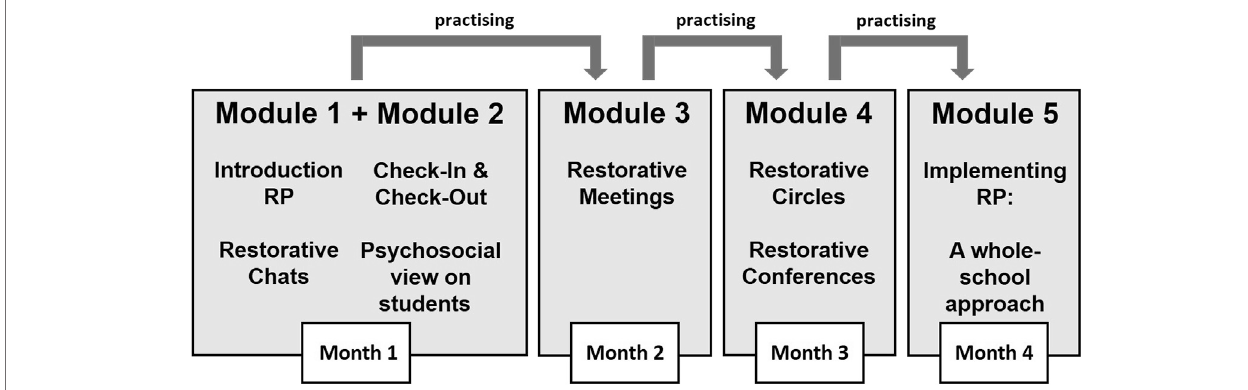
FIGURE 1 | Module overview of teacher training in RP.